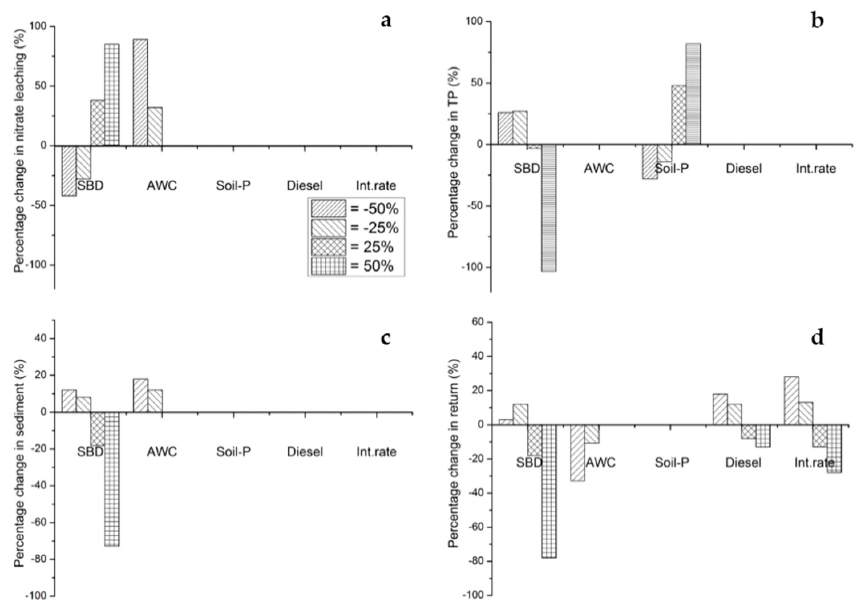
Figure 4. Sensitivity analysis at VNWY showing impact of changing input parameters (SBD = soil bulk density, AWC = available water content, Soil-P = soil phosphorus concentration) on ( a ) nitrogen leaching; ( b ) TP runoff; ( c ) sediment loss and ( d ) return to management.